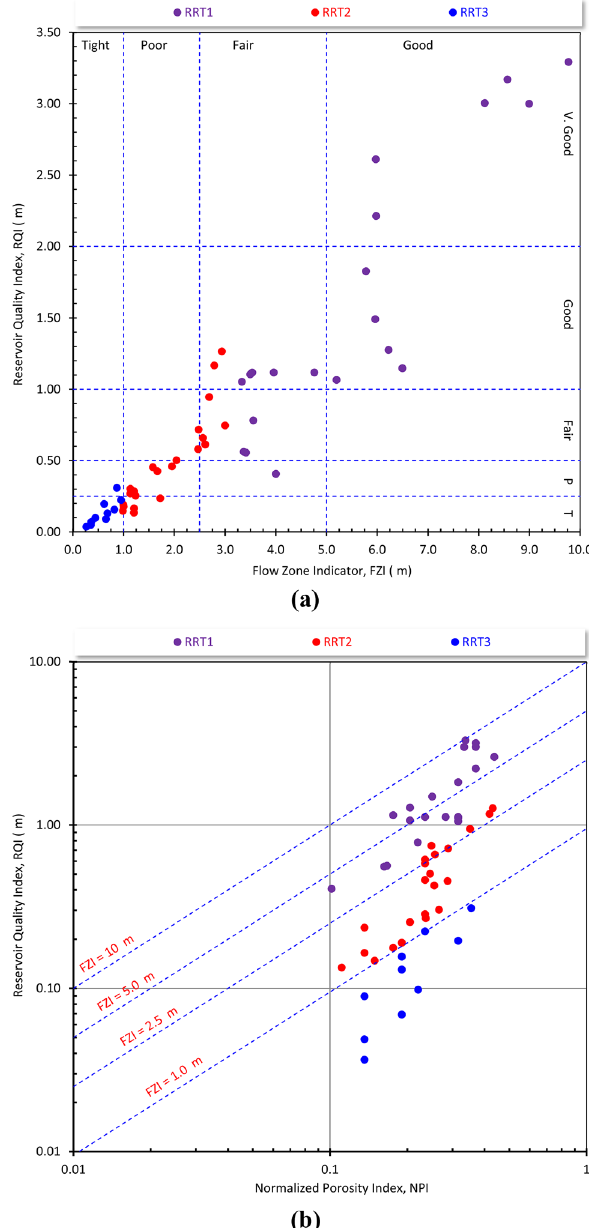
Fig. 17 Dependence of the reservoir quality index (RQI) of the core samples on a permeability, and b porosity. P and T refer to poor and tight qualities, respectively